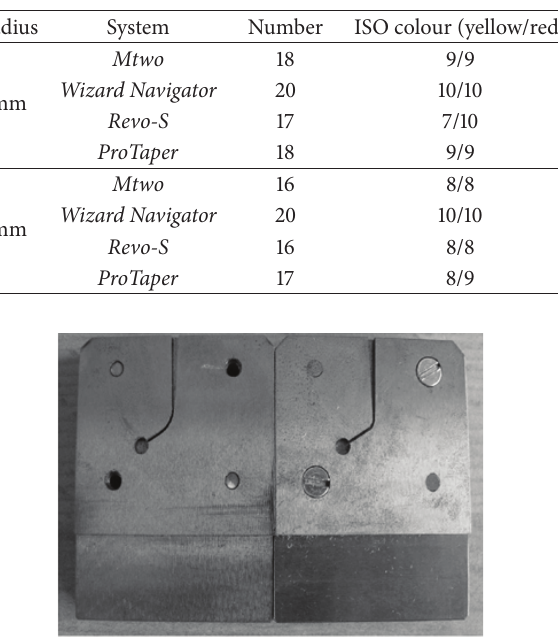
Table 1: Numbers of four Ni-Ti rotary instruments of the size specified by ISO standards (yellow for size 20, red for size 25) tested for the canal of 3 mm and of 5 mm radius of curvature.